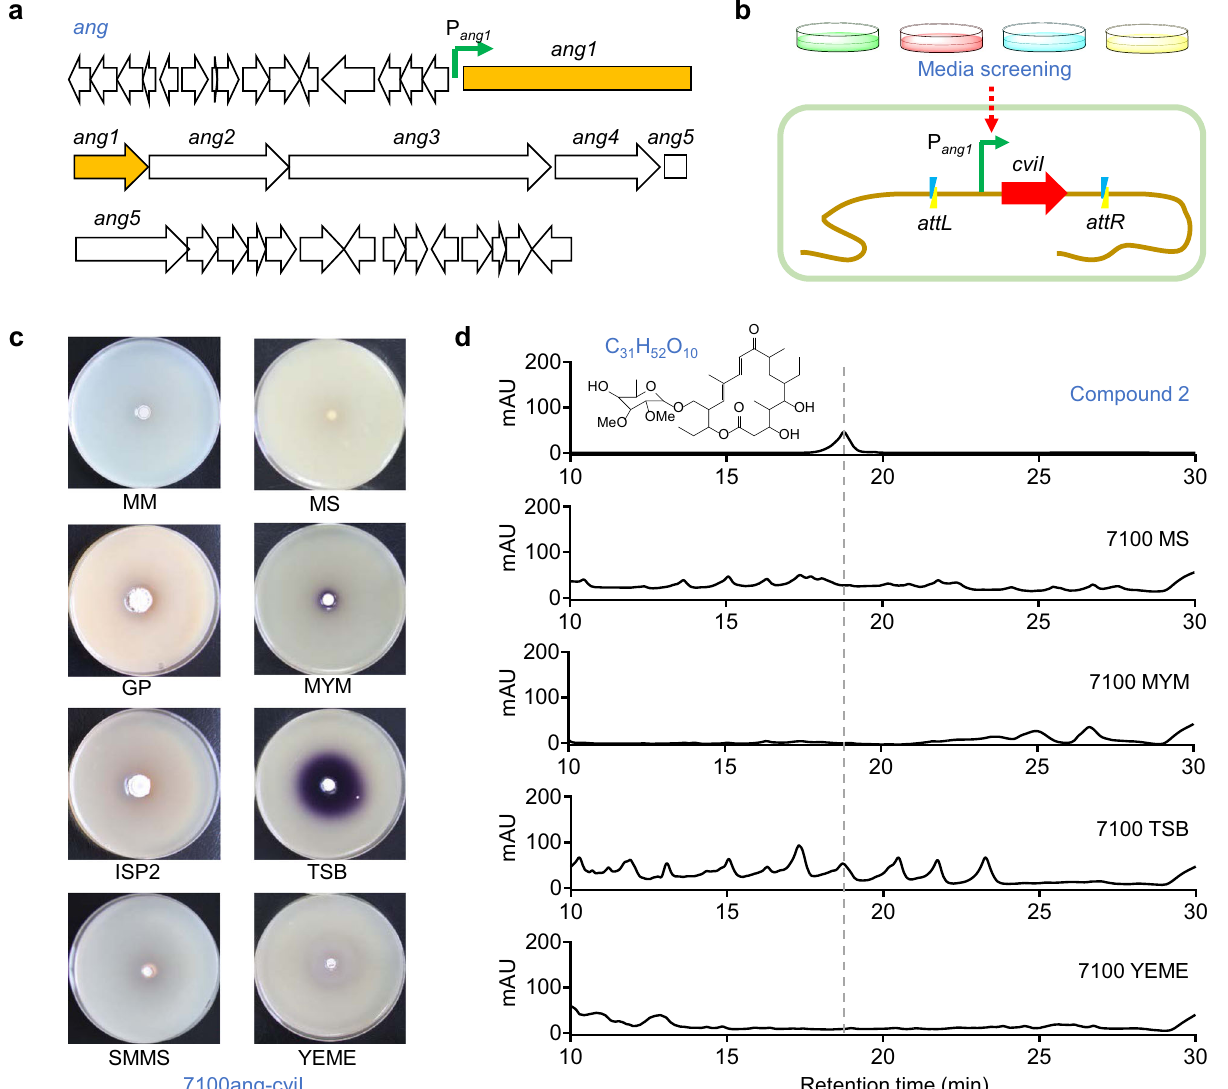
Fig. 3 VRS-bAHL-guided identi fi cation of the activated ang gene cluster. a Genetic organization of ang gene cluster in S. ansochromogenes 7100. b Schematic illustration of VRS-bAHL-guided identi fi cation of activated ang gene cluster through culture media screening. c Induction of violacein production in CV026 by reporter strain 7100ang-cviI ( S. ansochromogenes 7100 harboring pPang1-cviI with cviI driven by P ang1 , a promoter of ang1 in ang gene cluster, on pIJ10500K) grown on eight types of agar media (MM, GP, ISP2, SMMS, MS, MYM, TSB and YEME). Double-layer plate method was performed to detect AHL production in 7100ang-cviI. The purple pigment area and intensity indicate the expression level of the reporter gene ( cviI ). d HPLC analysis of tylosin analogs in S. ansochromogenes 7100 cultured on some of the representative media. Compound 2 standard was used as reference. Dashed line indicates the peak of Compound 2. Data shown in c and d are representative of two independent experiments that displayed similar